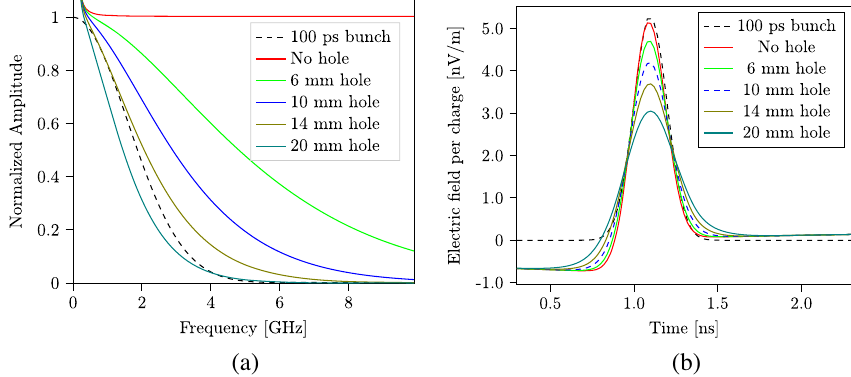
FIG. 7. (a) Frequency response as a function of hole size for β ¼ 0 . 15 at monitor distance R ¼ 1 . 0 m. Frequency spectrum of a 100 ps bunch is marked with dashed lines. (b) Calculated electric field for a broadband detector at 85° for an input of 100 ps bunch for different hole sizes in the